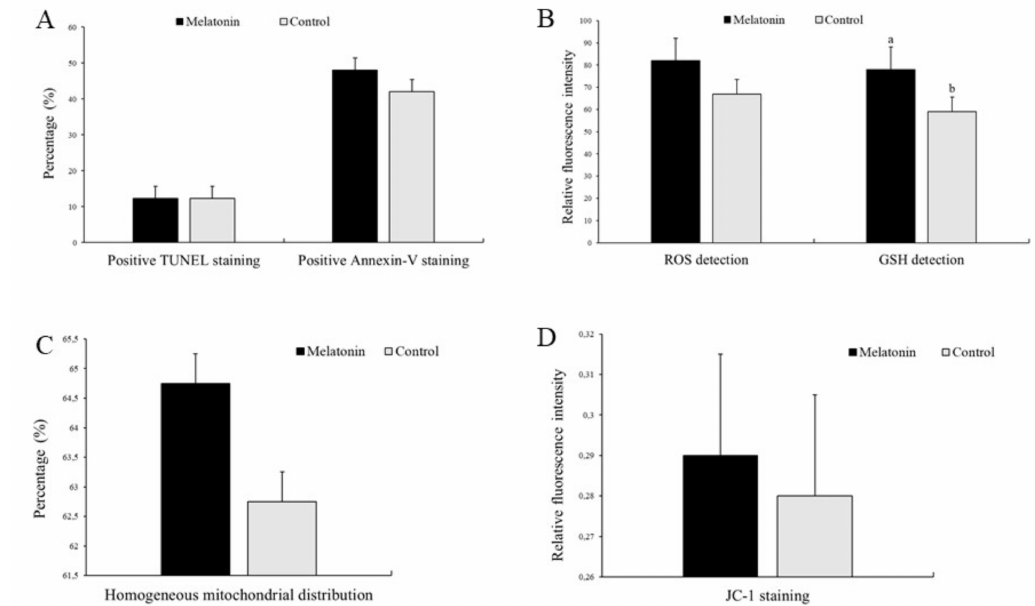
Figure 7. E ff ect of melatonin supplementation on sheep oocytes’ ( A ) early apoptosis (positive Annexin V staining) and DNA fragmentation (positive TUNEL staining); ( B ) ROS and GSH levels; ( C ) homogeneous mitochondrial distribution; ( D ) mitochondrial membrane potential: red (high membrane potential) / green (low membrane potential) fluorescence ratio (JC-1 staining); Results are expressed as mean ± SEM; a,b Di ff erent letters indicate di ff erences ( p ≤ 0.05) among